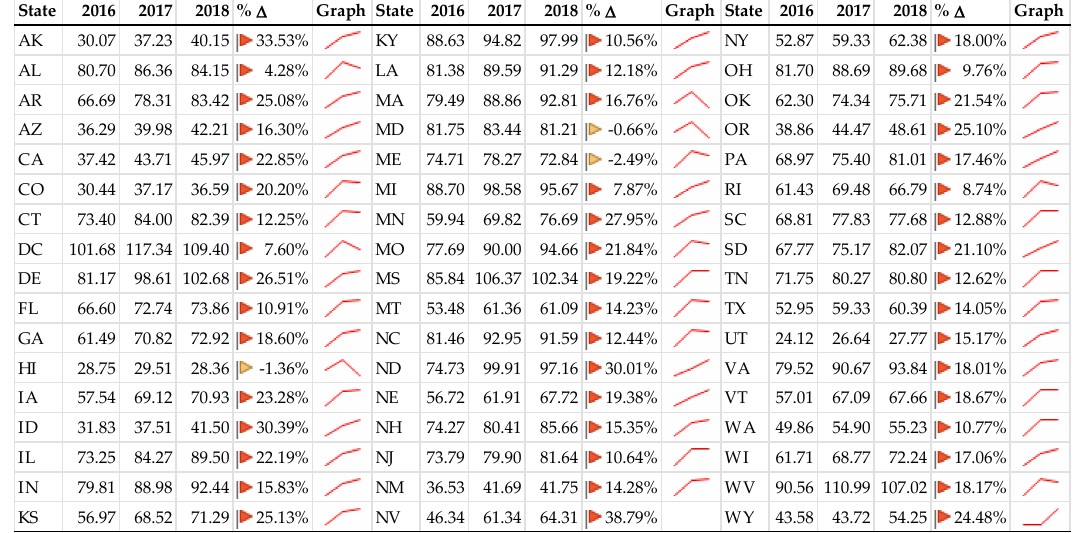
Figure 11. Diagnoses per 1000 by year by state.